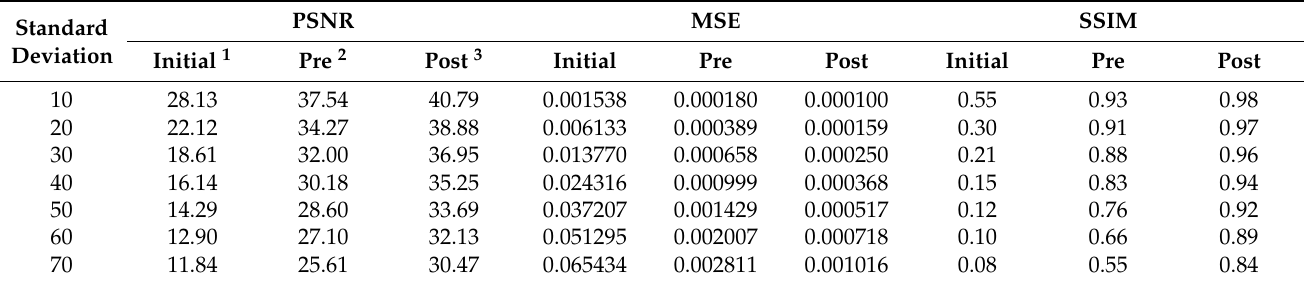
Table 10. Quantitative stress test for the synthetic